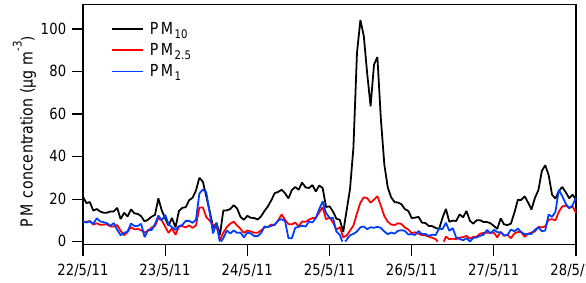
Fig. 1. PM 1 mass concentration measured at the SMEAR III sta- tion, together with PM 2 . 5 and PM 10 mass concentrations measured at another site (Kallio) in Helsinki between 22 and 28 May